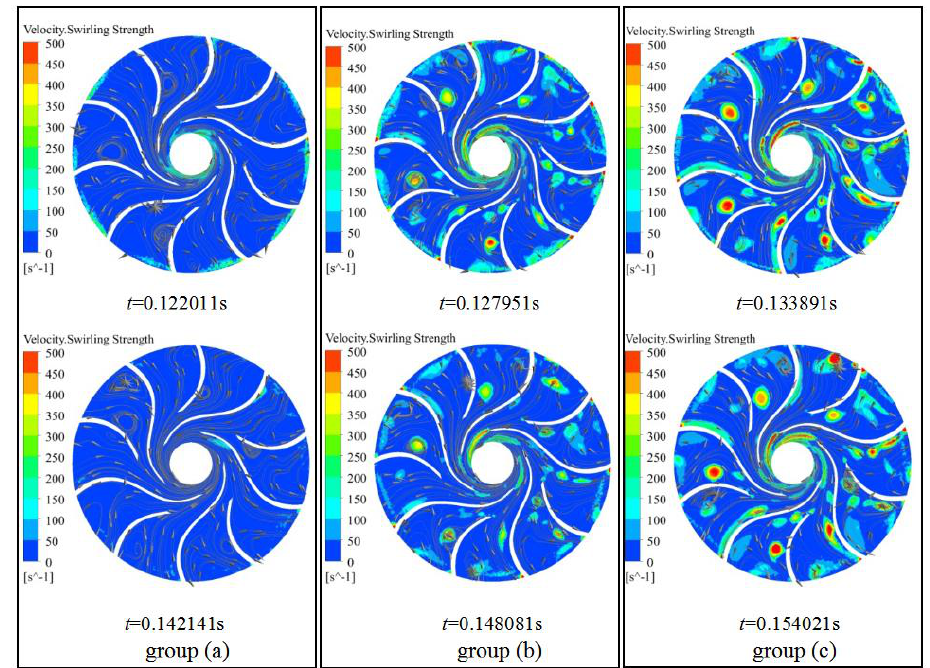
Figure 9. Streamline and swirling strength contour of impeller.